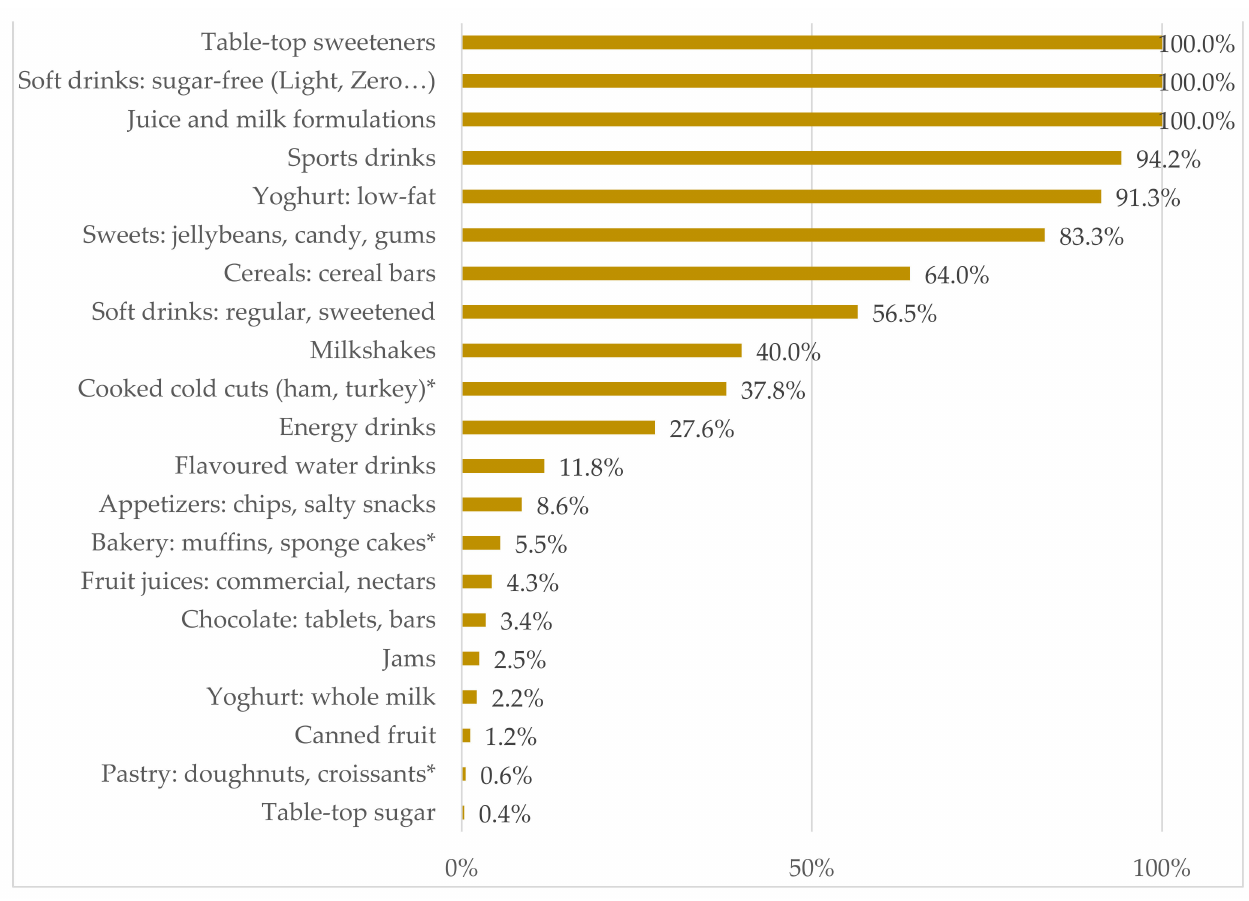
Figure 2. Presence of low- and-no-calorie sweeteners (LNCS) in all food products contributing to LNCS consumption. * LNCS found was sorbitol, for which the declared use was not as a sweetener but as humectant or as